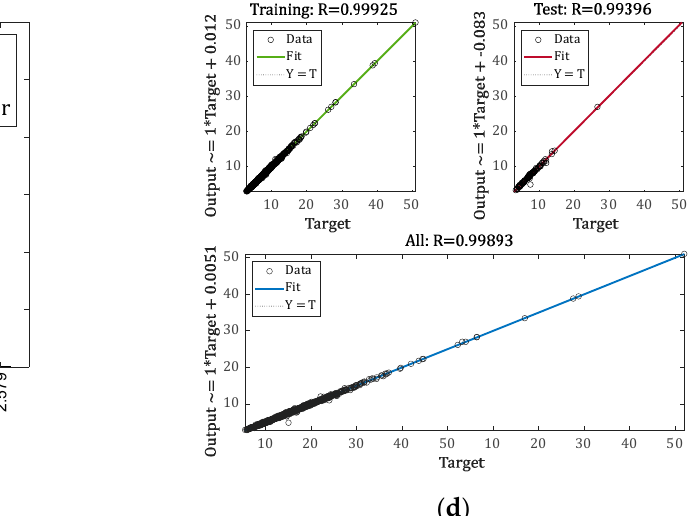
Figure 7. Specific information of BPNN-based surrogate model for sensitivity quantification: ( a ) Performance (MSE); ( b ) Training state; ( c ) Error histogram; ( d ) Regression.